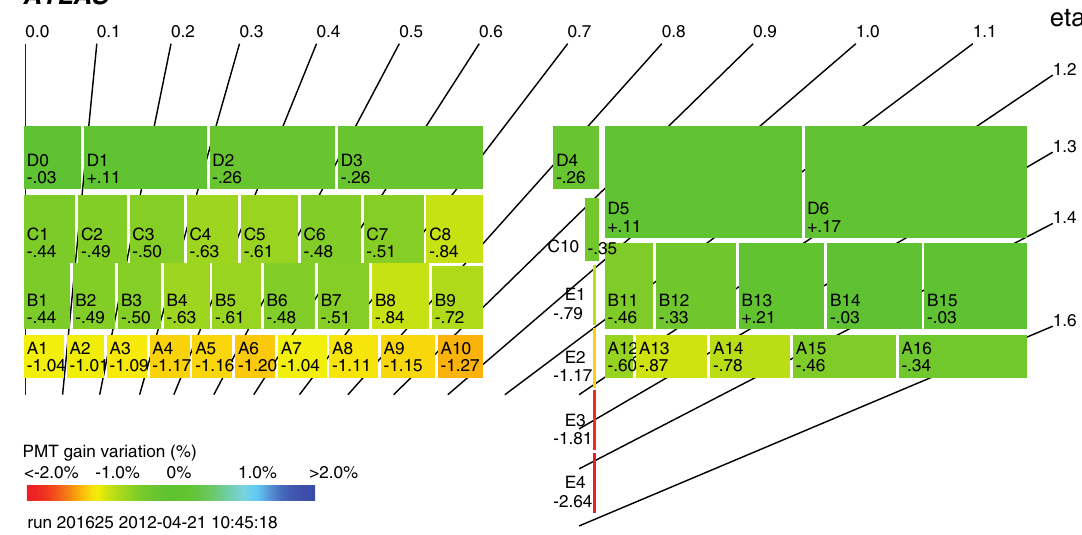
Fig. 15 The mean gain variation in the PMTs for each cell type aver- aged over φ between a stand-alone laser calibration run taken on 21 April 2012 and a laser run taken before the collisions on 19 March 2012. For each cell type, the gain variation was defined as the mean of